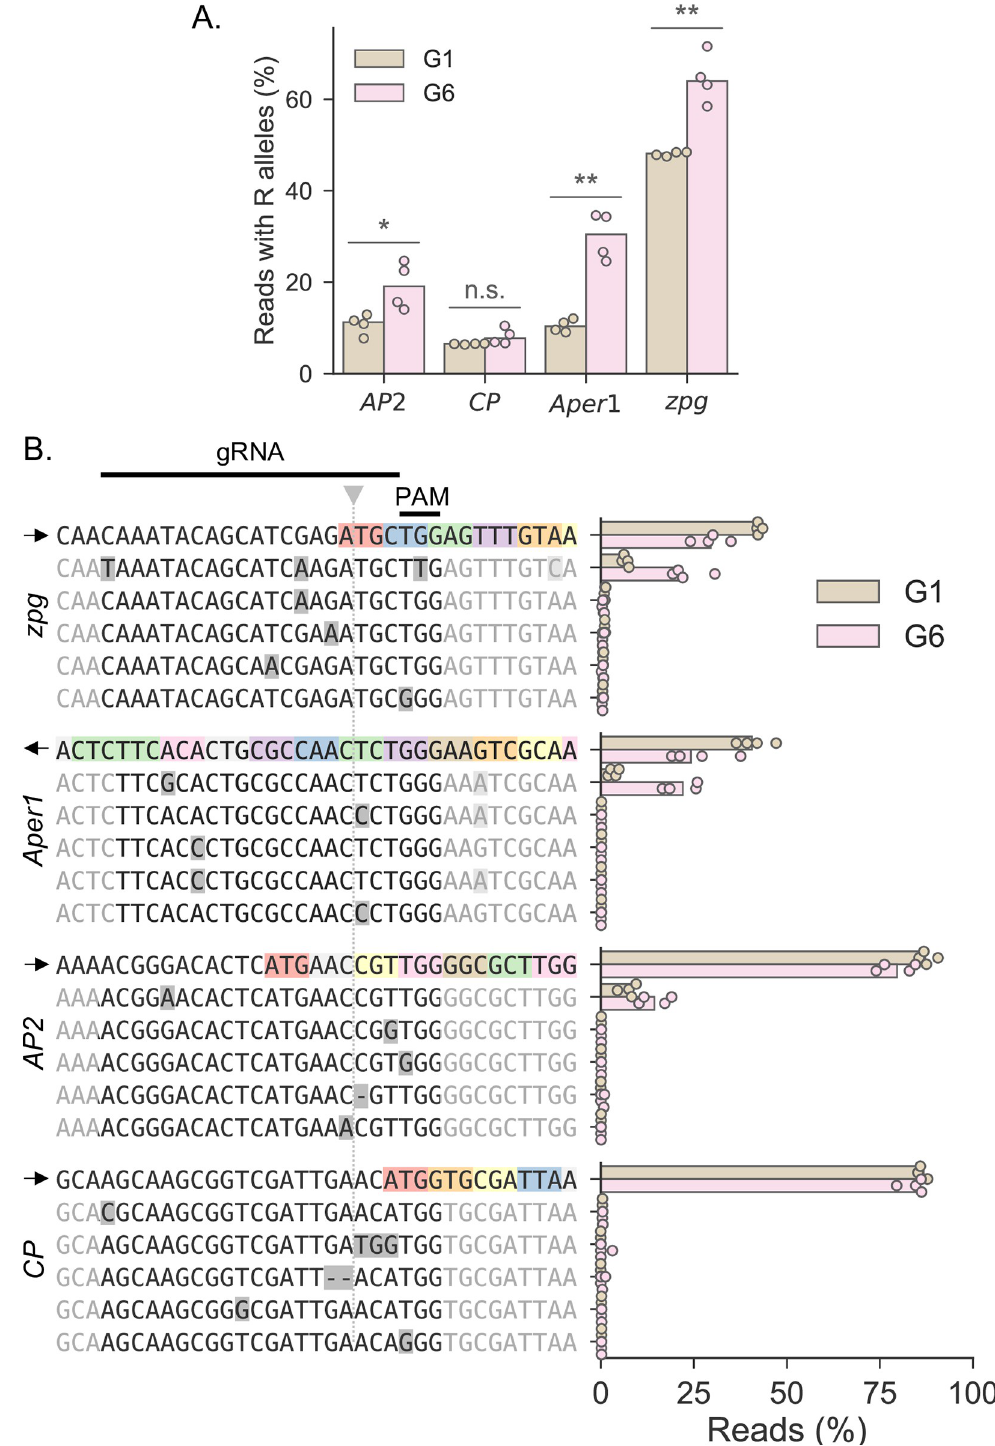
Fig 5. Analysis of target site variants in the caged populations at all 4 loci. A : Percentage of reads with a predicted cleavage resistant allele of any type at each locus, at generations 1 (G1, brown) and 6 (G6, pink). Each data point represents a cage population. Paired t-tests were used to compare G1 and G6 at each locus ( AP2 : t = -4.003, p = 0.028; CP : t = -1.921, p = 0.151; Aper1 : t = -7.603, p = 0.005; zpg : t = -6.540, p = 0.007) B : Shown are the reference allele (top) and the 5 most common target site resistance variants observed at each locus (differences highlighted in grey) and the percentage of